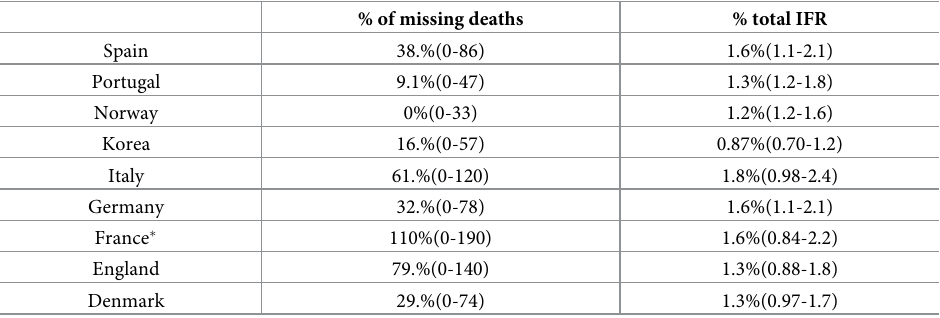
Table 2. Country-dependent estimates. We estimate the percentage of unreported number of deaths for each country together with the expected fatality ratio once included these estimated missing deaths. In the parenthesis we include the expected values if the current death counting was perfect (no missing deaths, left side of the parenthesis) and if heavy under-counting was present, such as the one observed when comparing with number of deaths with COVID-19 in the death certificate (right side of the